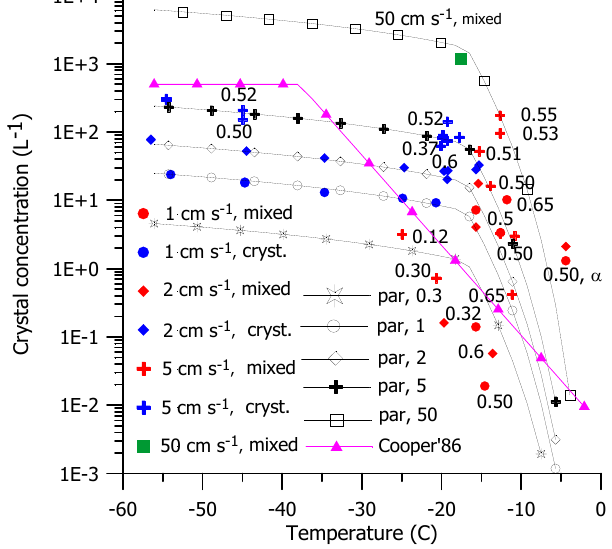
Fig. 5. Parameterized parcel model simulations from KC scheme with DF mode shown in Fig. 4 for the 5 values of w = 0.3, 1, 2, 5 and 50 cm s -1 are compared to the experimental data from the 6 field campaigns described in Eidhammer et al. (2009) and indicated in the legend. The almost vertical curve labeled PDA-KC is from Philips et al. (2008). This curve, labeled “KC” in PDA08, was calculated from eq. (1.7) for N c here at S w = 1 (RHW = 100 %) for each T separately, without any model simulations and was a wrong attempt to represent the T -dependence in KC theory with excluded S w – dependence and its negative feedback. As this figure illustrates, this curve is substantially different from the real T -dependences in KC scheme represented by the parameterized KC curves. This PDA-KC curve from PDA08 actually represents the old T - dependence from the classical theory based on the J.J. Thomson’s (1888) Eqs. for r cr and ∆ F cr with account for only T -dependence but without S w -dependence (see PK97, eq. 9-38).